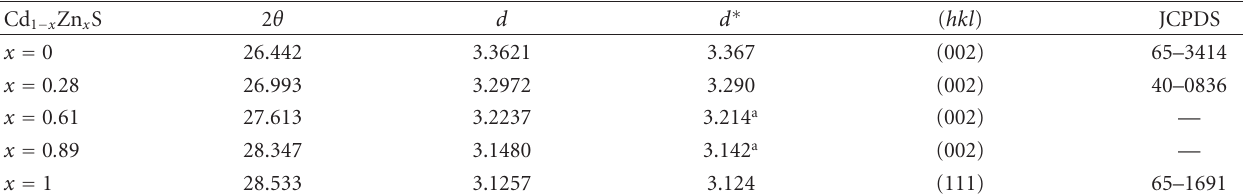
Table 2: XRD results for Cd 1 − x Zn x S thin films.